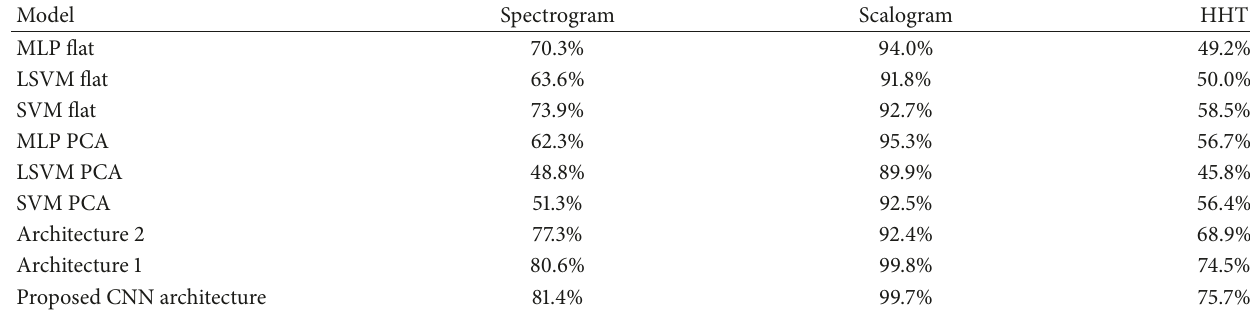
Table 6: Prediction accuracies for 32 × 32-pixel image